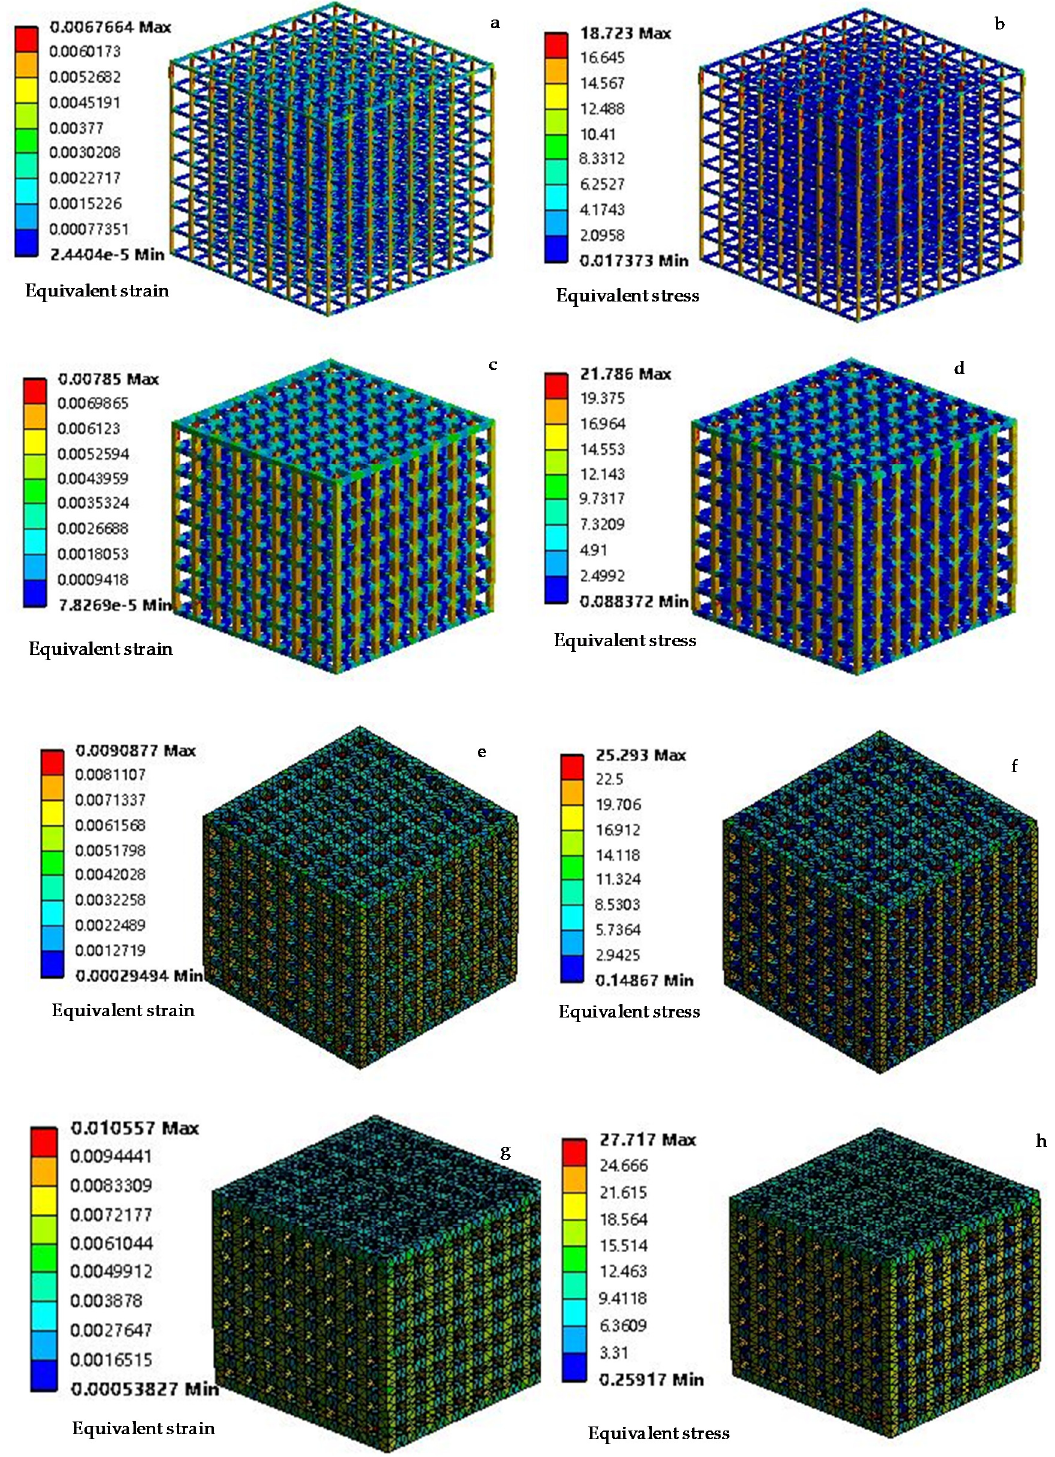
Figure 3. Calculation results of the deformation behavior (elastic deformation stage) of the four models. ( a , b ) Model 1; ( c , d ) model 2; ( e , f ) model 3; ( g , h ) model 4.